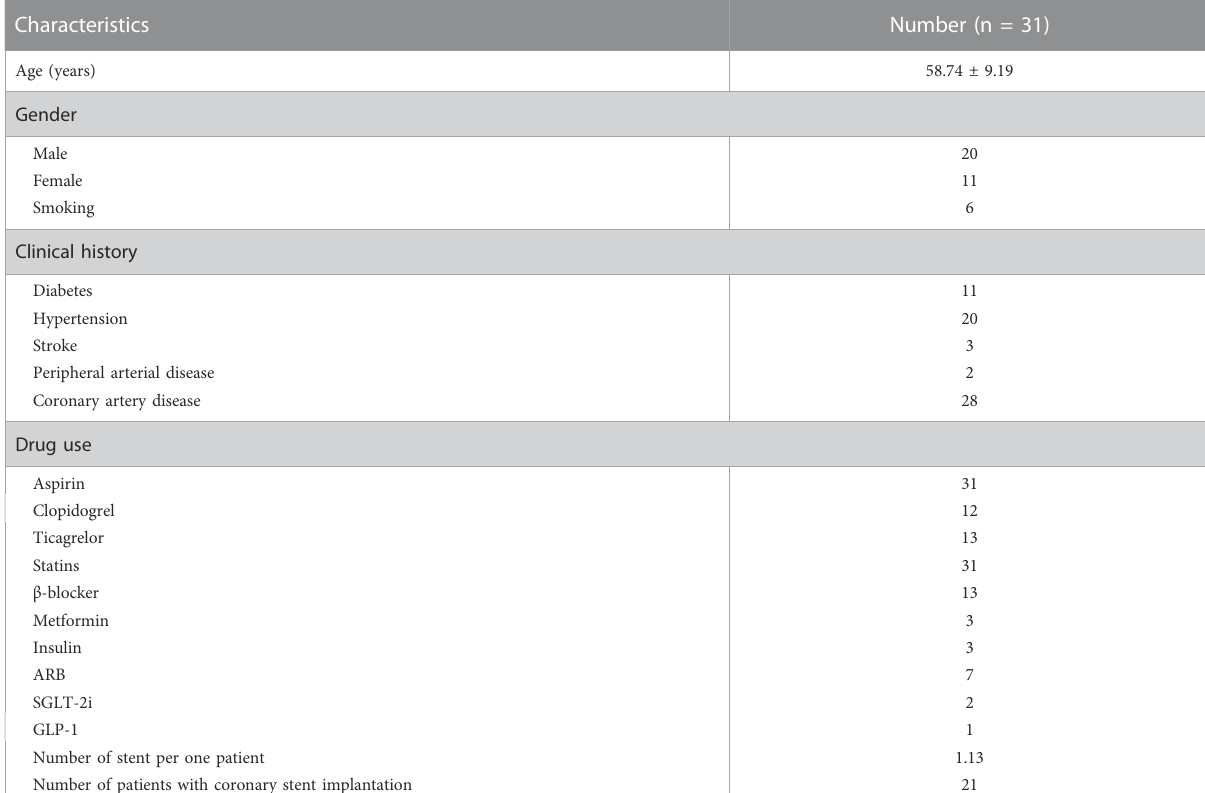
TABLE 1 Clinical characteristics of the patients.